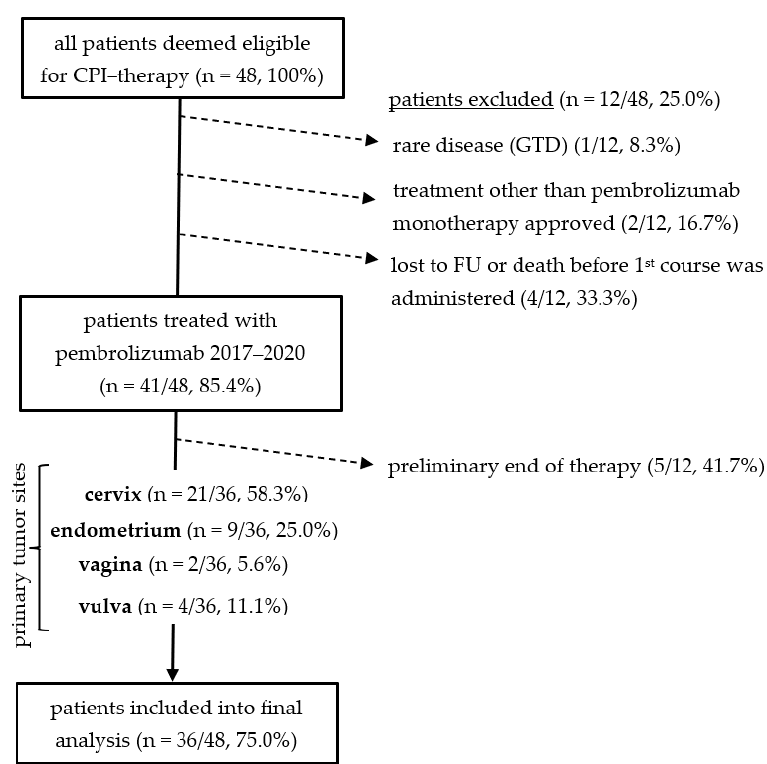
Figure 1. Flowchart depicting the constitution of the patient cohort evaluated at final analysis (n = 36). Out of 48 patients with gynecological cancers initially referred to the immunooncologic tumor board for CPI treatment evaluation, seven patients were excluded for not meeting primary inclusion criteria; another five patients were excluded as they were not re-evaluated after four cycles according to iRECIST criteria for preliminary end of treatment or missing follow-up.